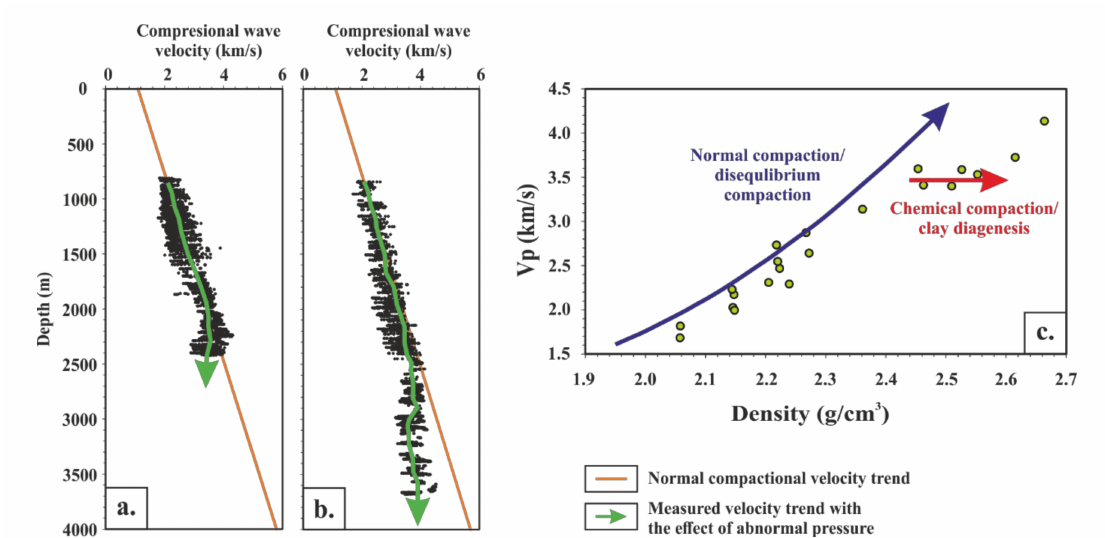
Figure 10. ( a ) Compressional wave velocity-depth plots from W-59 that suggest a slight lag from the normal compaction trend; ( b ) Compressional wave velocity-depth plots from W-13 that clearly show the lag from the normal compaction trend from 2400 m; ( c ) Compressional wave velocity and bulk density cross plots prove the presence of chemical compaction or clay diagenesis as an overpressure generation